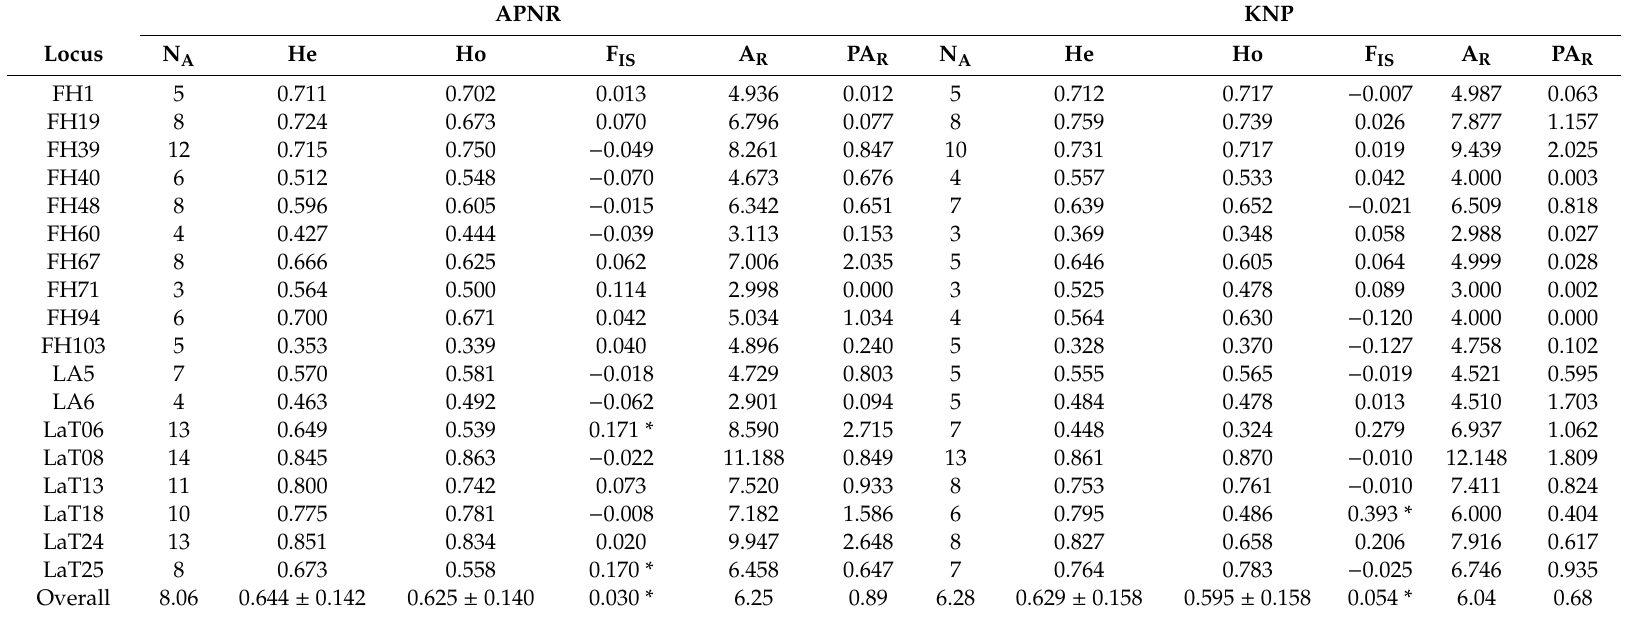
Table 1. Estimates of genetic diversity based on 18 microsatellite loci for elephants in the APNR ( n = 248) and KNP ( n =